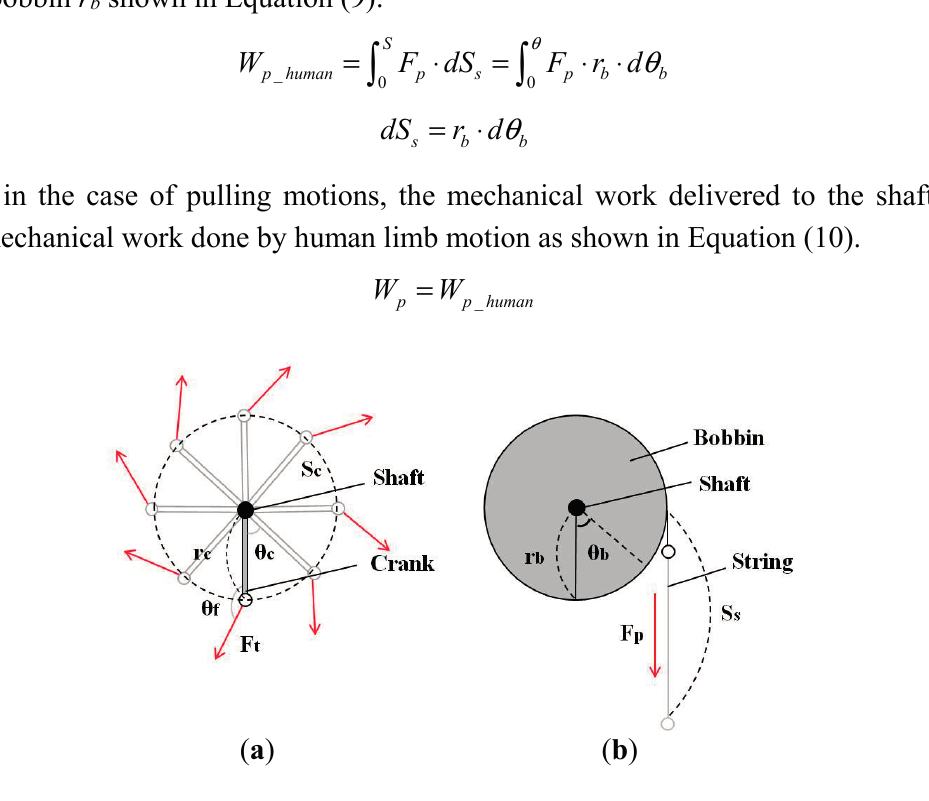
Figure 2. Analytic models of operation by human upper limb motion. ( a ) Turning; ( b ) Pulling. Table 1. Symbols in Figure